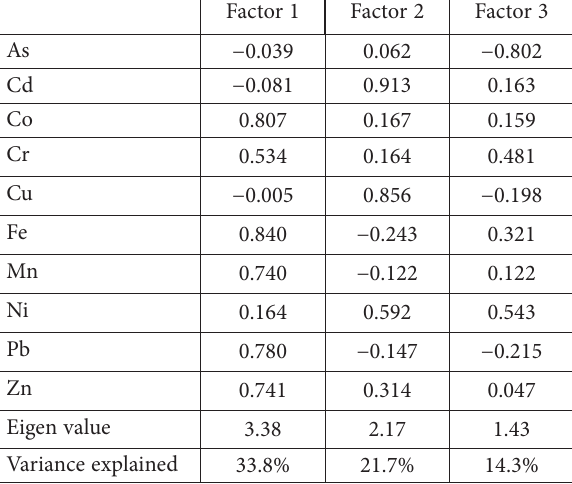
Table 3. Results of factor